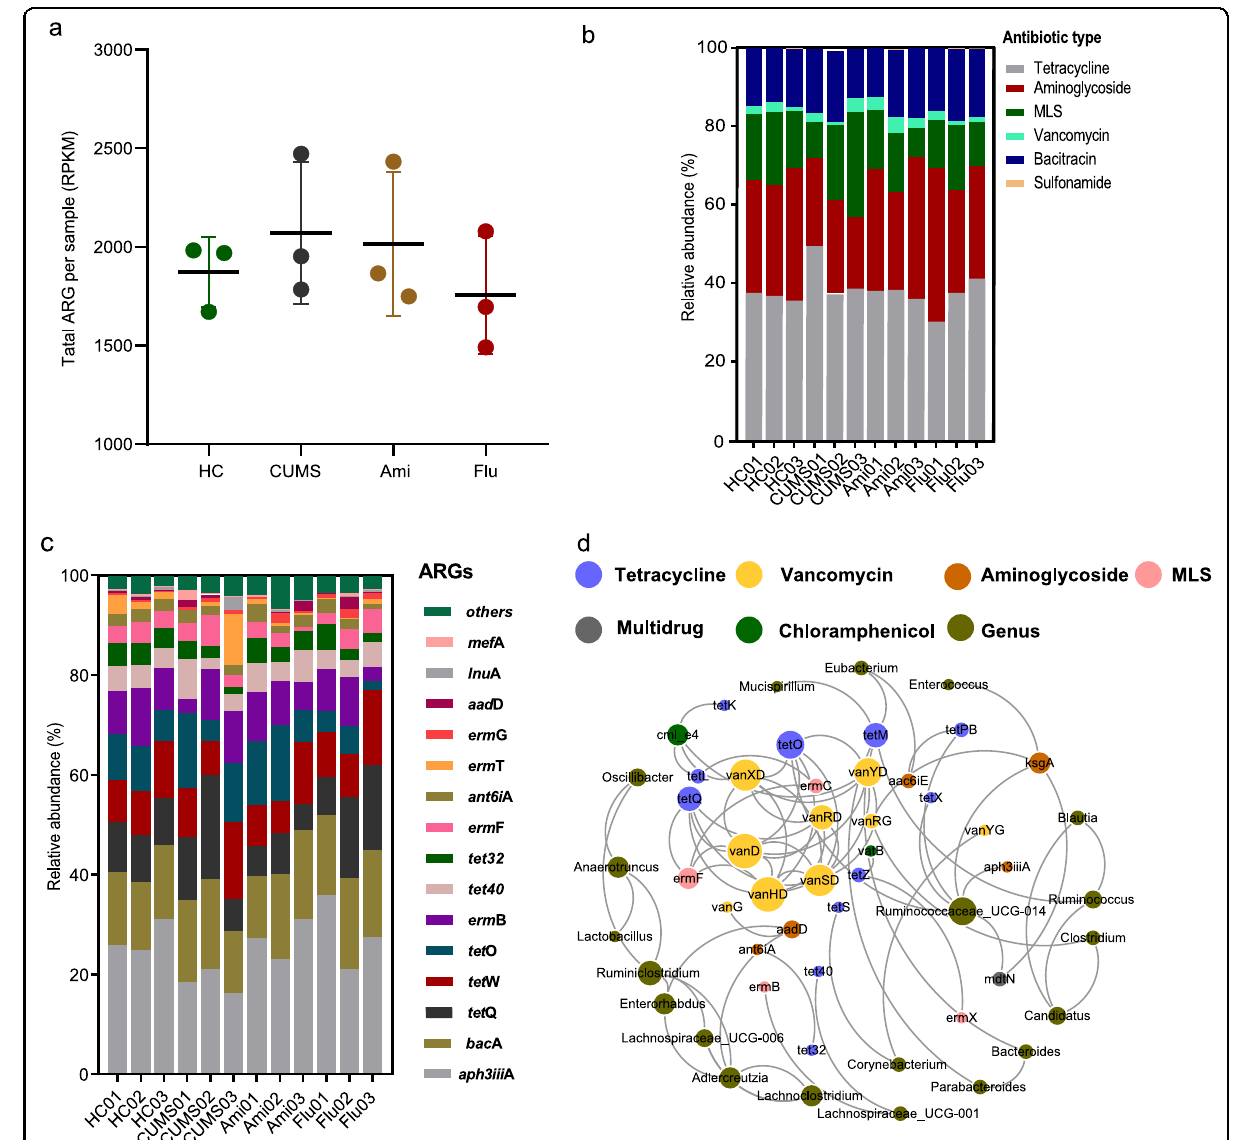
Fig. 5 Antibiotic resistance gene analysis via metagenomics sequencing. a Scatter plot of the total ARG reads per kilobase per million mapped reads per sample (RPKM). b Relative ARG abundance per antibiotic type. c Relative abundance of the 15 most common ARGs. ARG abundance comprising less than 1% of the total abundance in all samples are represented as ‘ others ’ . d Co-occurrence network analysis showing the correlation between resistance genes and bacterial taxa at the genus level. Only connections with a strong (Spearman ’ s ρ > 0.8) and signi fi cant ( P -value < 0.01) correlation are presented in the network. The size of the nodes (circles) is proportional to the number of connections (the degree). MLS Macrolide – Lincosamide – Streptogramin